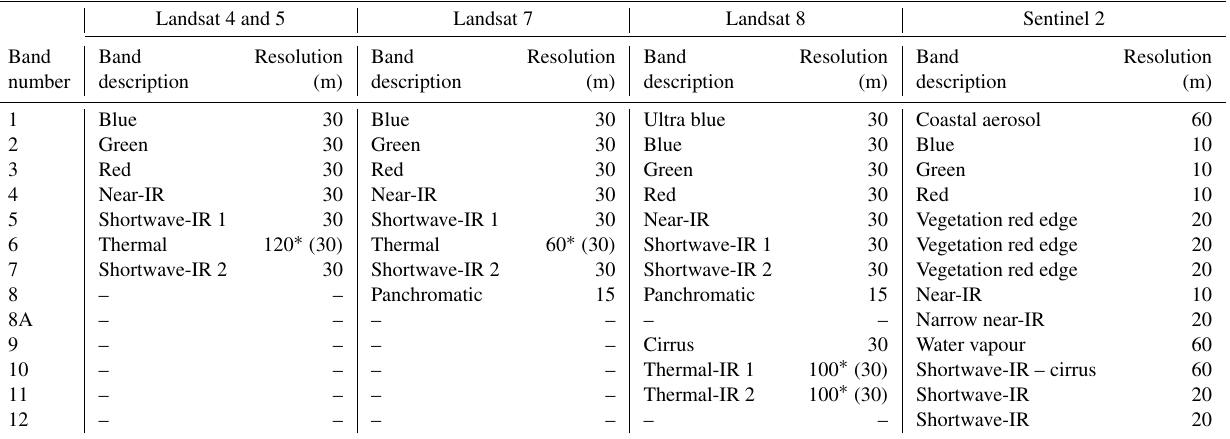
Table 2. Description of bands for optical imagery satellites.